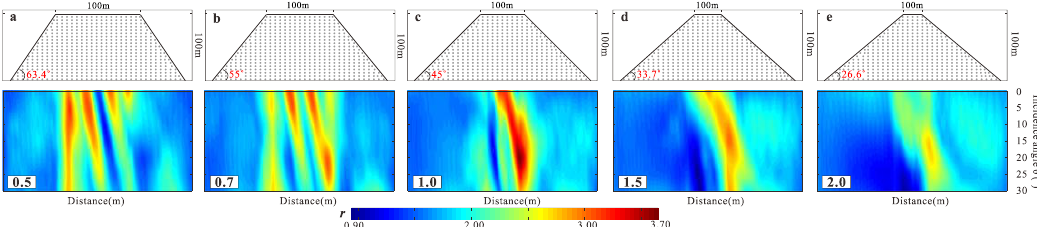
Figure 24. Variations of the seismic responses along the slope ridges and slope crests of the real amplification ratios ( r ) of PGA with varied angles of wave incidence at different slope inclinations. ( a ) slope inclination of 0.5, ( b ) slope inclination of 0.7, ( c ) slope inclination of 1.0 ( d ) slope inclination of 1.5 ( e ) slope inclination of 2.0